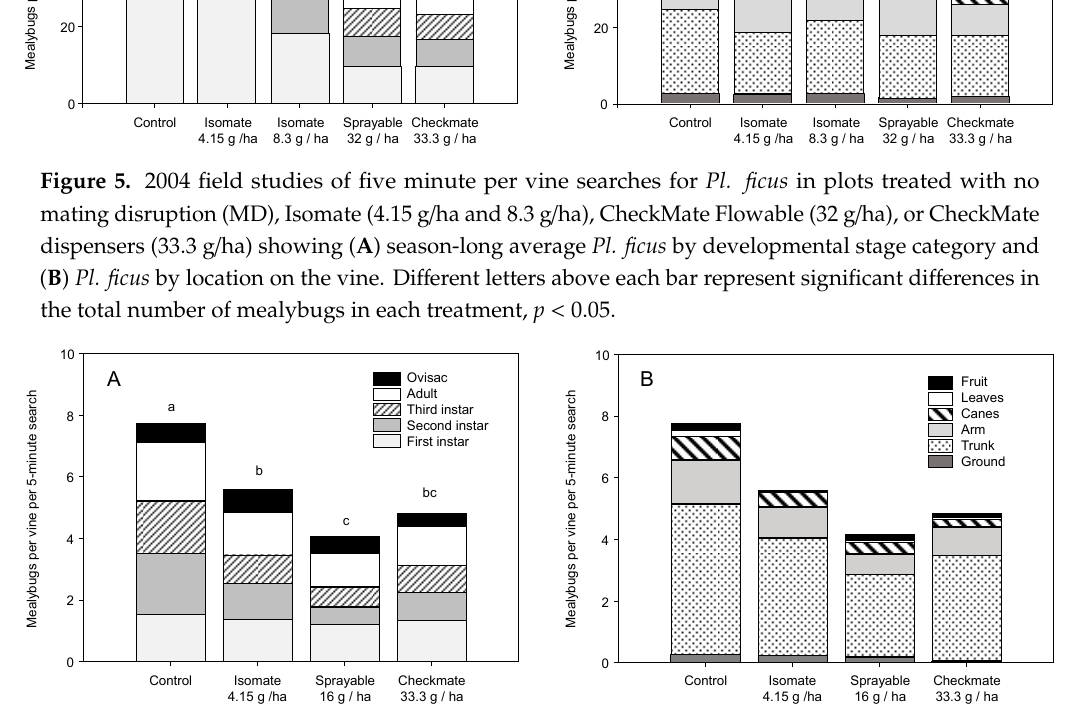
Figure 6. 2005 field studies of five minute per vine searches for P. ficus in plots treated with no MD, Isomate (4.15 g / ha), CheckMate Flowable (16 g / ha), or CheckMate dispensers (33.3 g / ha) showing ( A ) season-long average Pl. ficus by developmental stage category and ( B ) Pl. ficus by location on the vine. Different letters above each bar represent significant differences of the total number of mealybugs in each treatment, p < 0.05.